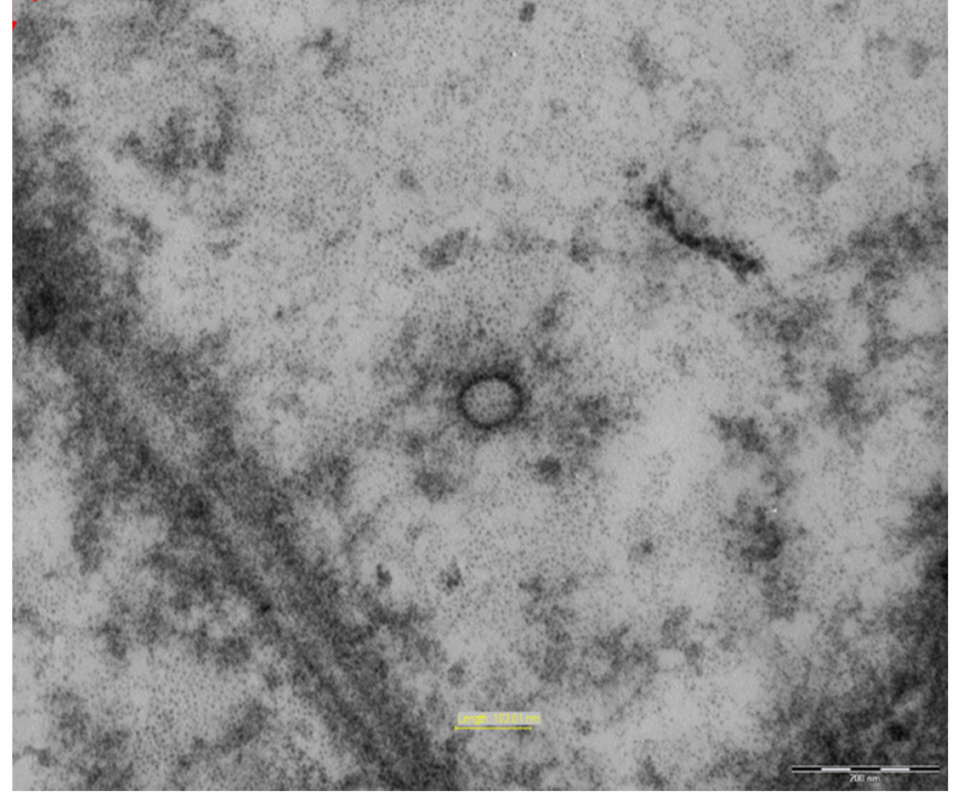
Figure 3. Circular formations with a 100–130 nm diameter were observed, with peripheral electron dense spicules, which are likely viral particles in the cytoplasm of the perivillary histiocytes. (Electron microscopy, 71,000 ×